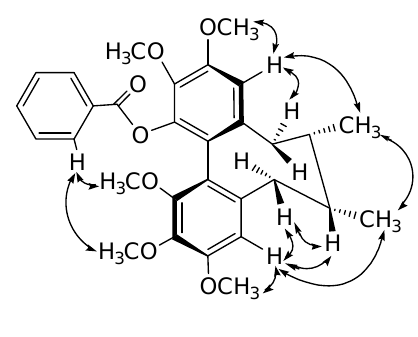
Figure 5 . Key NOESY Correlations of 2